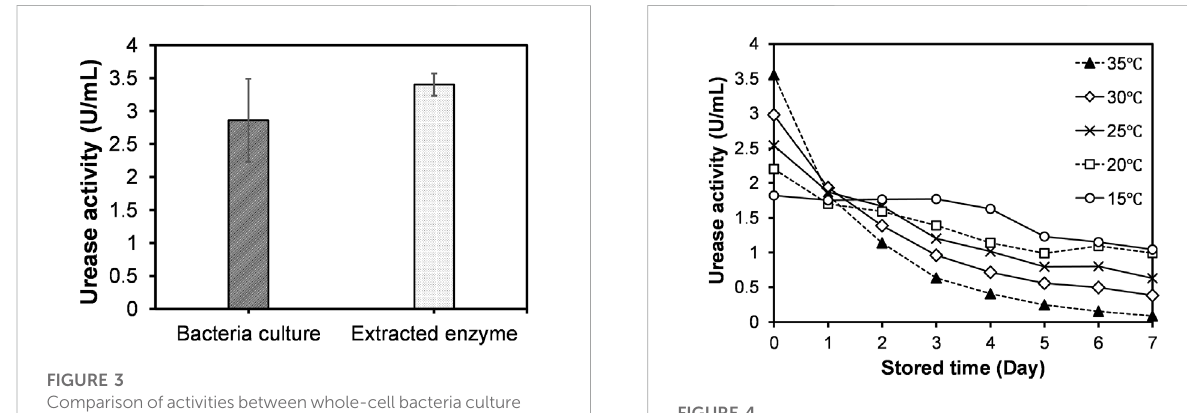
FIGURE 4 Variation of urease activity against time under different temperature